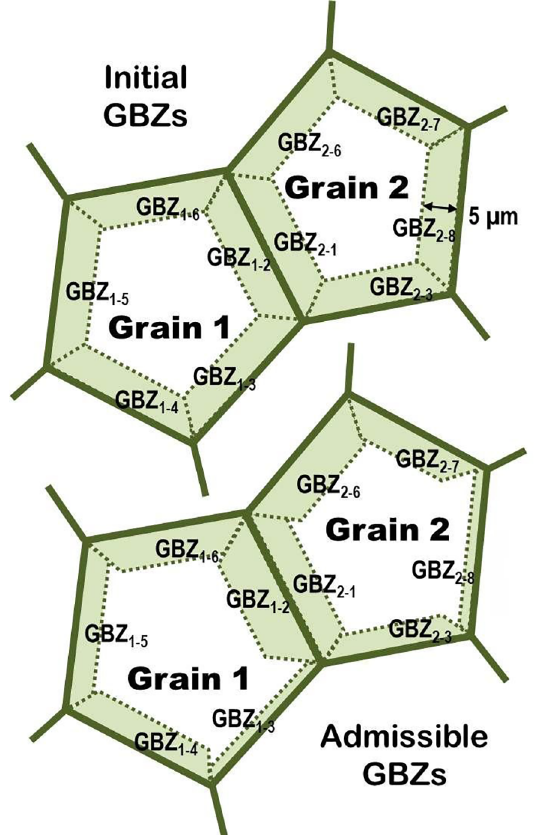
Figure 3. Schematic representation of the initial GBZ considered in the calculations and the admissible GBZs resulting from orientation gradient analysis.